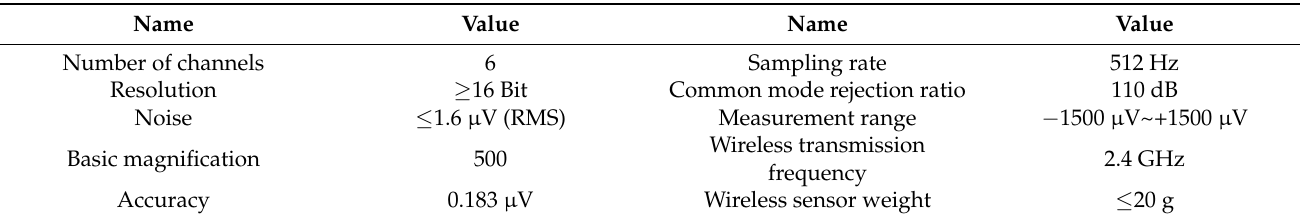
Figure 6. Schematic diagram of the airfield traffic pattern mission process.